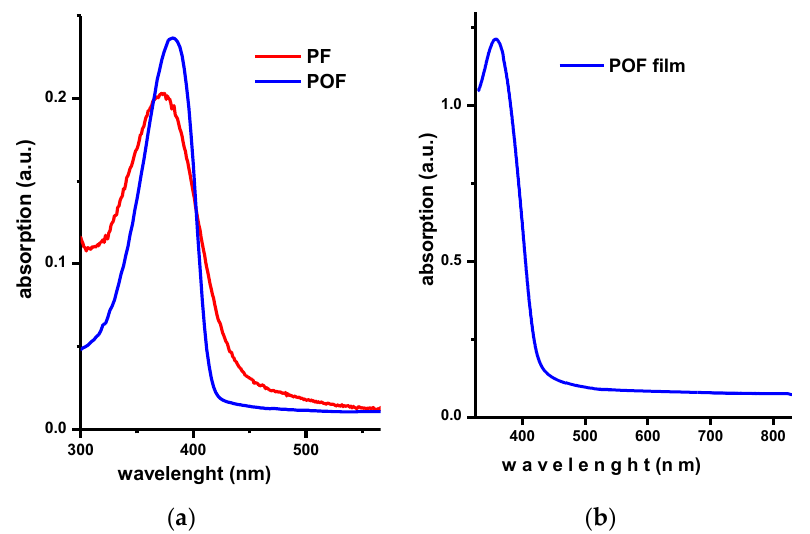
Figure 4. UV-vis spectra of the polyfluorene ( PF ) and poly(fluorene–oxadiazole) – POF , in solution ( a ) and film ( b ).